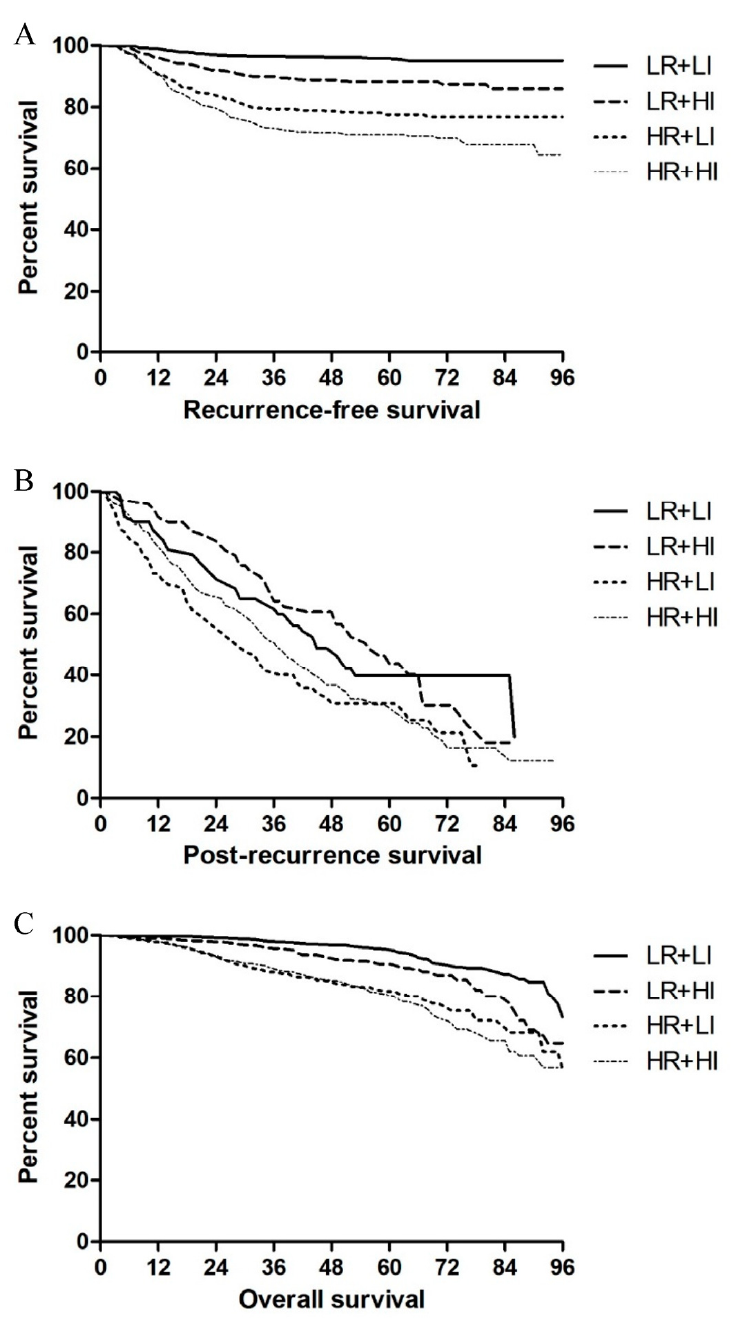
Figure 3. Kaplan–Meier analyses of ( A ) recurrence-free survival, ( B ) post-recurrence survival, and ( C ) overall survival according to surveillance intensity and predicted recurrence risk. Abbreviations: LI, low surveillance intensity; HI, high surveillance intensity; LR, low-recurrence risk; HR, high-recurrence risk.